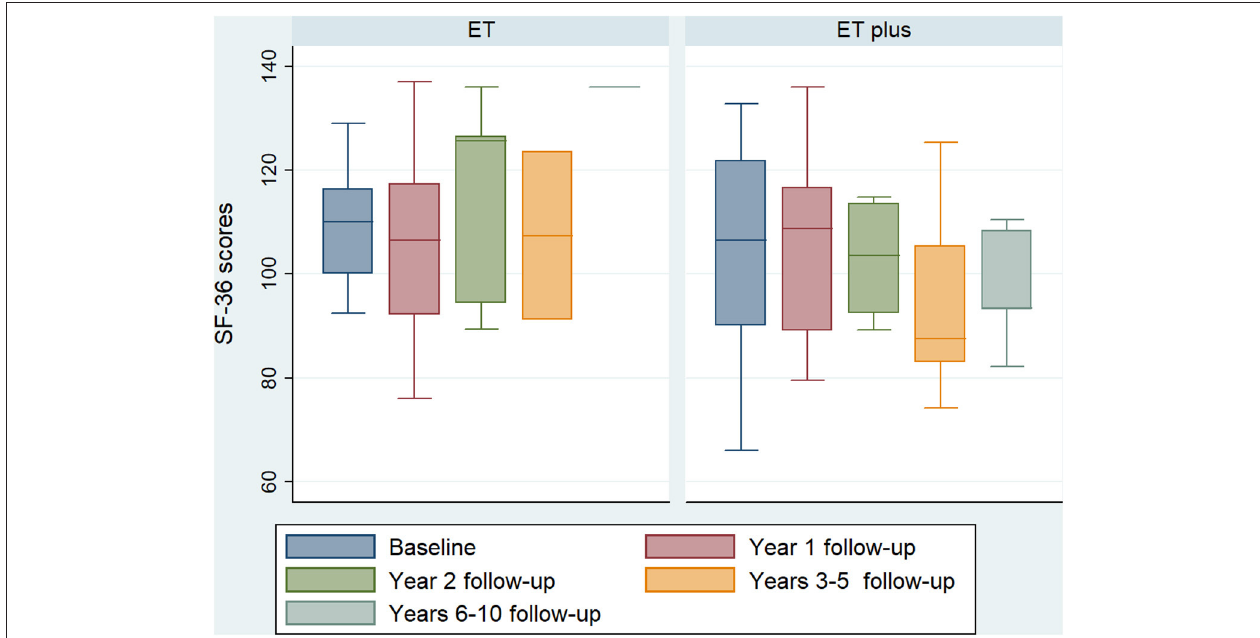
FIGURE 2 | ET vs. ET-plus quality of life outcomes. Boxplot of baseline and follow-up SF-36 scores at 1, 2, 3–5 and 6–10 years follow-up of ET and ET-plus patients. There are no significant differences between ET and ET-plus outcomes at each time point. (ET, essential tremor; ET-plus, essential tremor plus; SF-36, 36-Item Short Form Survey).